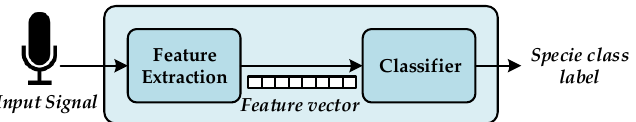
Figure 3. Block diagram of the birdsong recognition system where the main elements are depicted: ( a ) the feature extraction obtains a representation with lower dimensionality of the input signal with the aim of characterize it and ( b ) the classifier lebels the features extraction frames with a specie